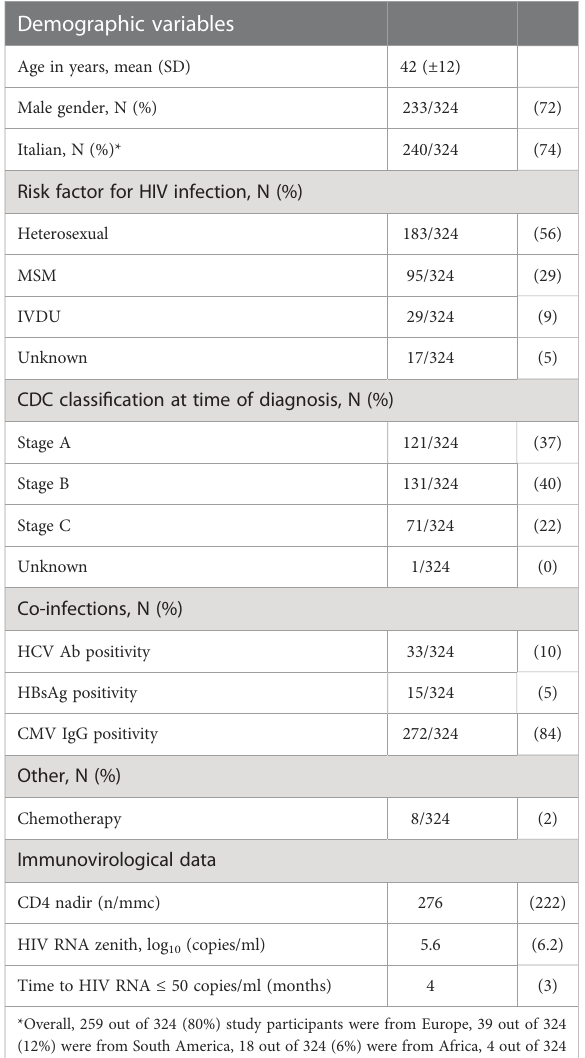
TABLE 1 Clinical and demographic characteristics of the study population.